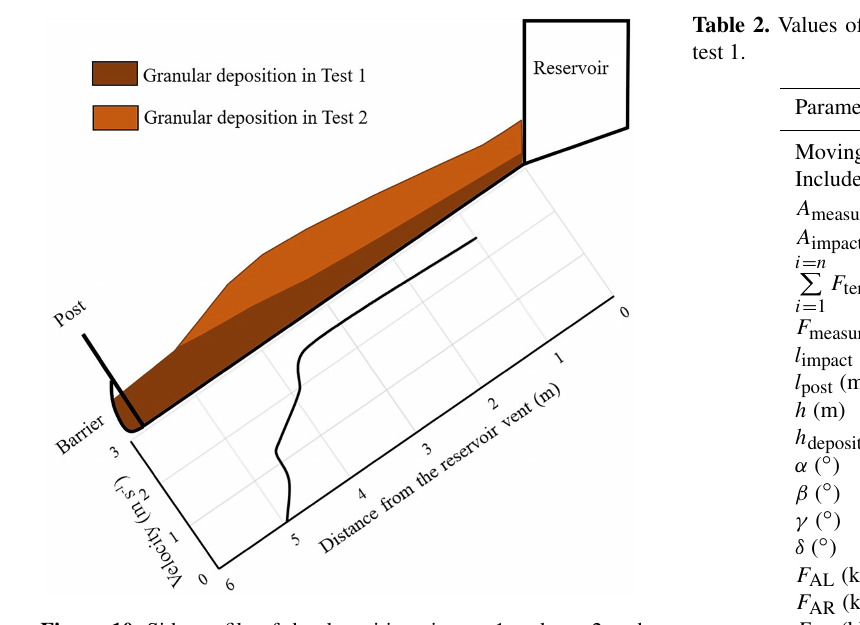
Figure 10. Side profile of the depositions in test 1 and test 2 and the velocity change of the granular flow in test 2 with the moving distance.